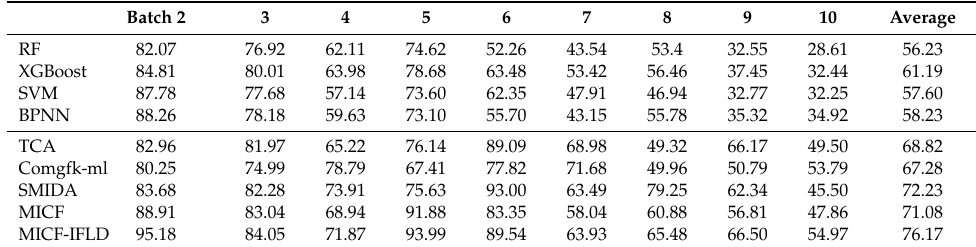
Table 3. Accuracy of classification obtained by the experiment results